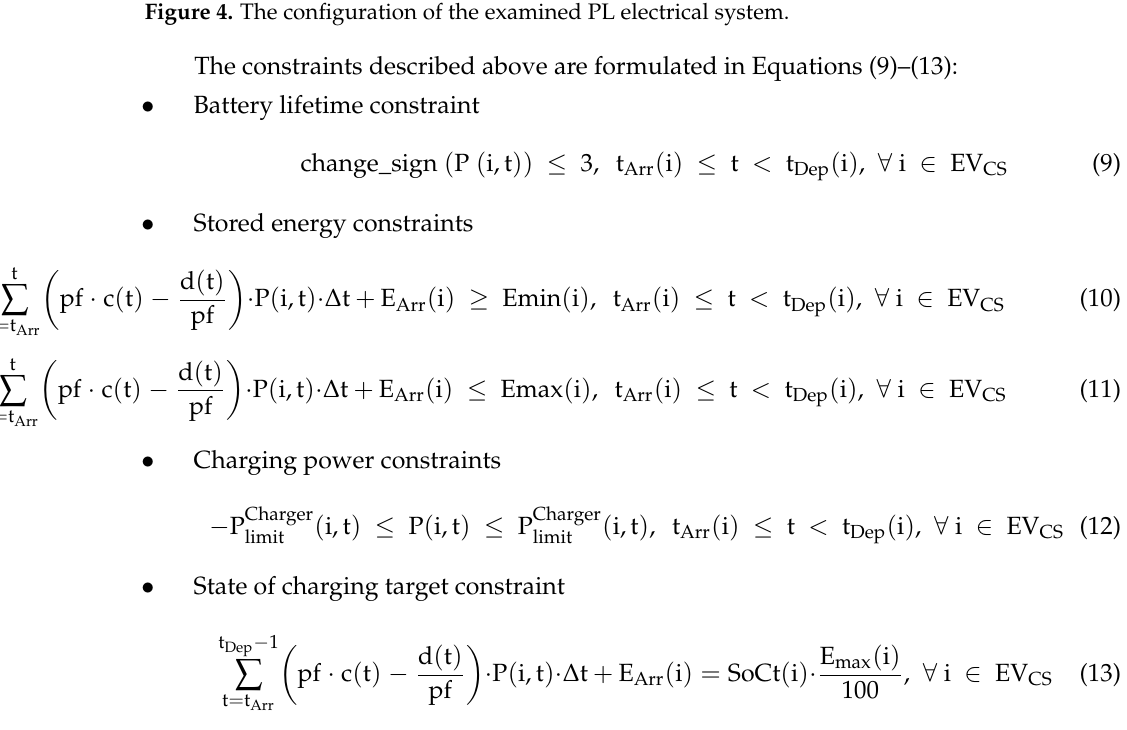
Figure 4. The configuration of the examined PL electrical system.